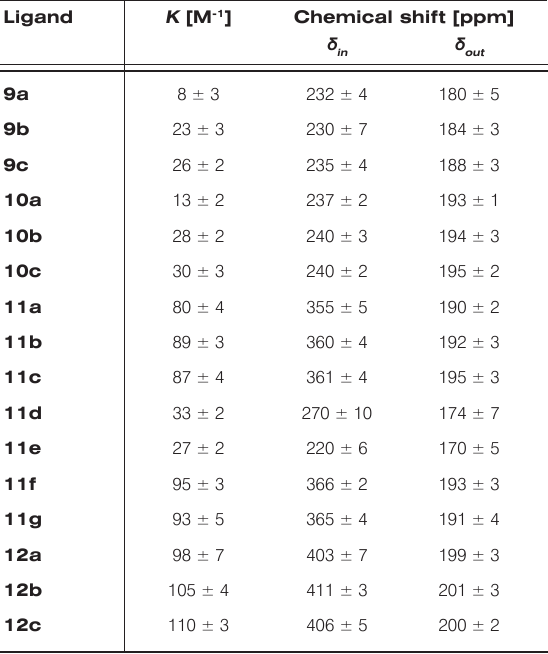
n.r. - formation of inclusion complex has not been detected (K < 2 M -1 ) Table 2. Results of the 129 Xe NMR titration experiments for siloxane ligands.